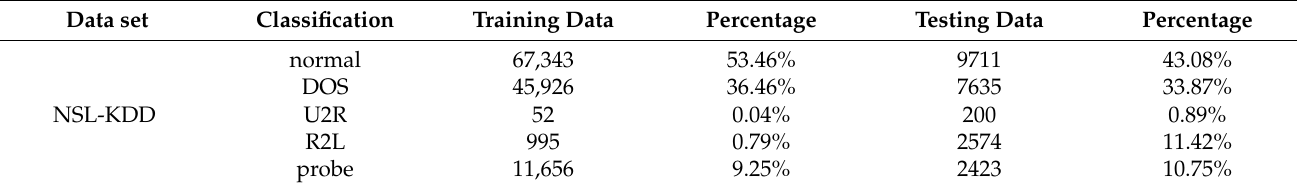
Table 3. The distribution of attack